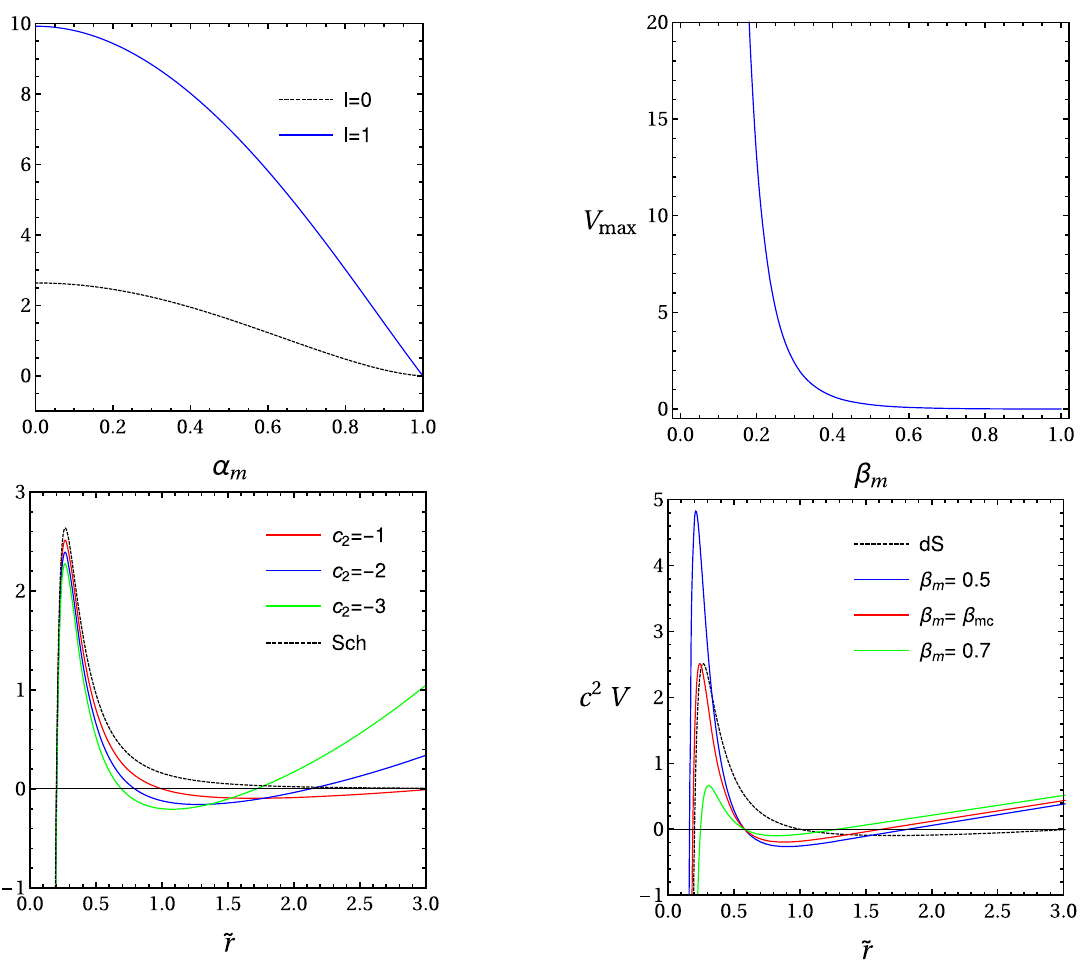
Fig. 4 The left panel shows the maximum of dRGT potential with (cid:18) = 0, ˜ M = 0.1, α g = 0.1, c = 1, and c 2 = − 1. The right panel shows the dRGT potential with (cid:18) = 0, ˜ M = 0.1, α g = 0.1, c = 1, and c 2 = −